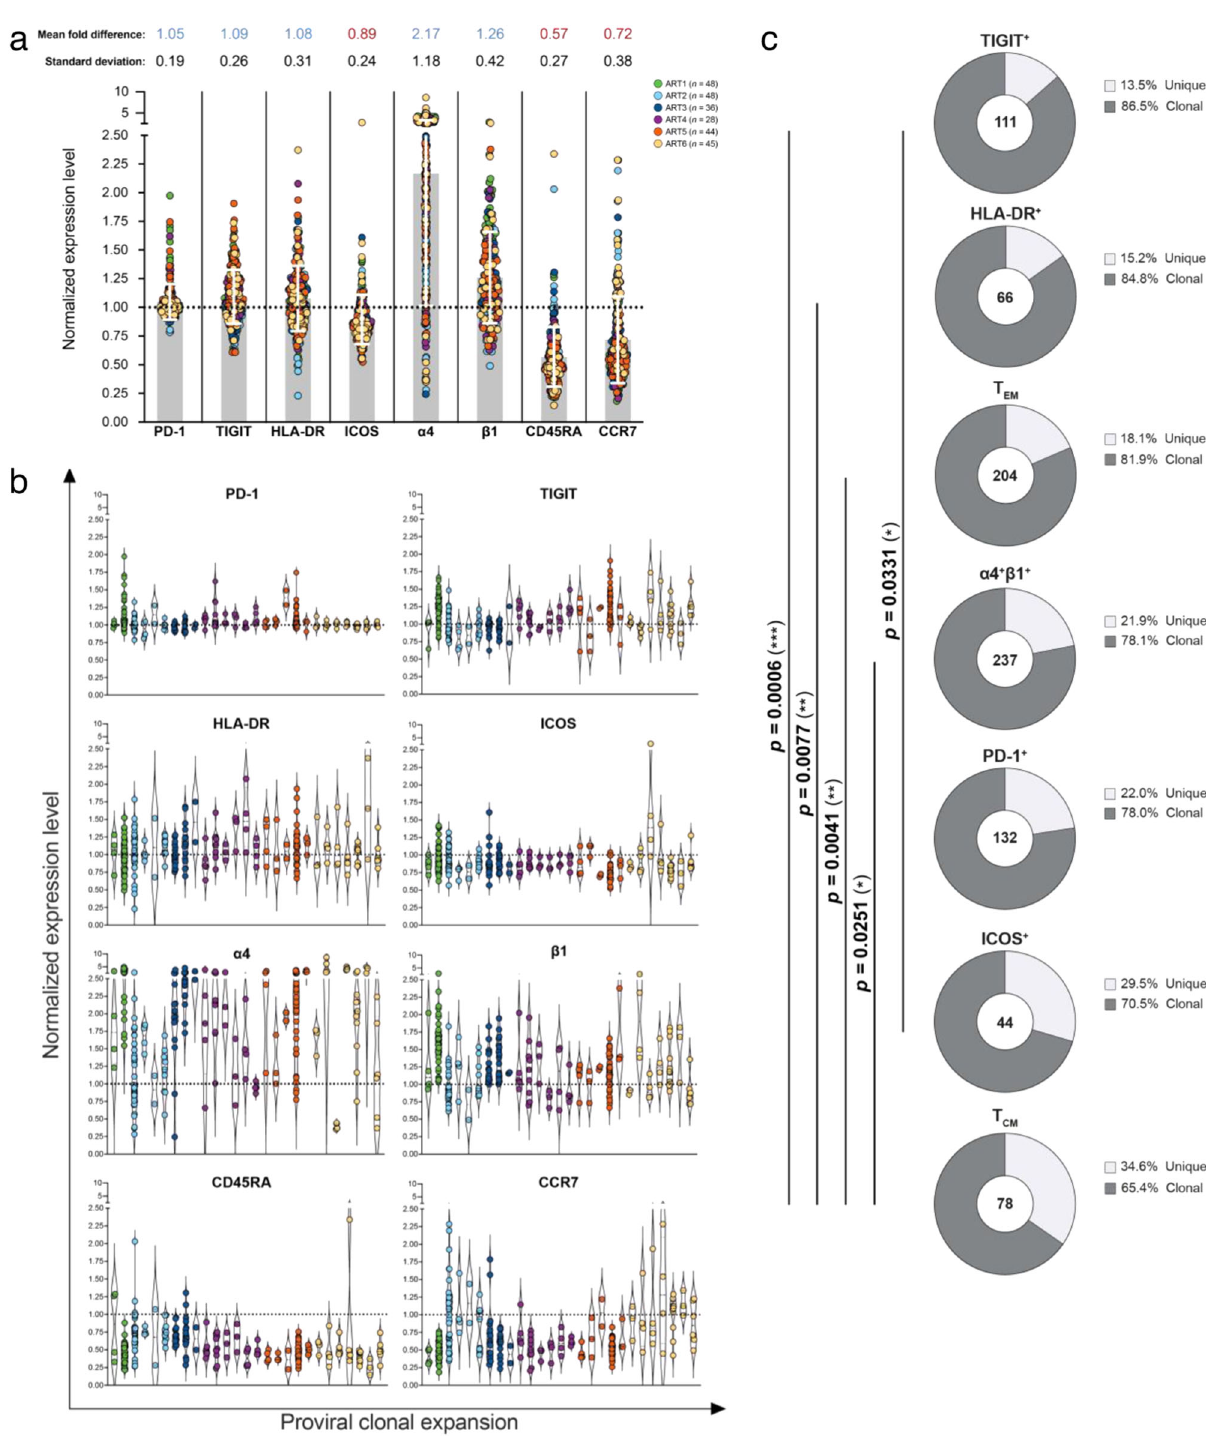
Fig. 4 | Phenotype of clonally expanded cells harboring inducible and translation-competent proviruses. Levels of expression of PD-1, TIGIT, HLA-DR, ICOS, α 4, β 1, CD45RA and CCR7 is represented by the ratio between the fl uores- cence intensity of a cellular marker on each p24+ single sorted-cell and the mean fl uorescenceintensityofthismarkeronallCD4+Tcellsfromthesameparticipant. A normalized expression level above or below 1 (dotted line) re fl ects a higher or lower expression of this marker on a given p24+ cell compared to all CD4+ T cells, respectively. Each dot represents a single-sorted cell and is color-coded by the participant. a Normalized expression levels of each marker for all clonally expan- ded p24+ cells ( n =239 independent clonally expanded proviruses). Mean fold